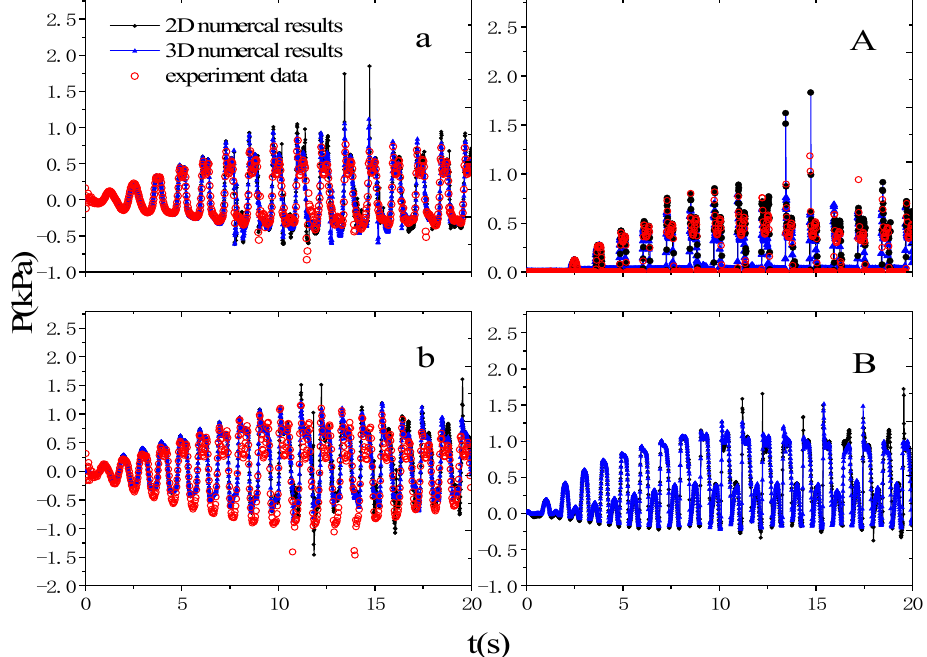
Figure 13. The comparison of the 2D and 3D numerical results ( a ) h = 90 mm, ω = 1.06 ω 1 , pressure on the bottom, ( A ) h = 90 mm, ω = 1.06 ω 1 , pressure on the free surface, ( b ) h = 200mm, ω = 0.96 ω 1 , pressure on the bottom, ( B ) h = 200 mm, ω = 0.96 ω 1 , pressure on the free